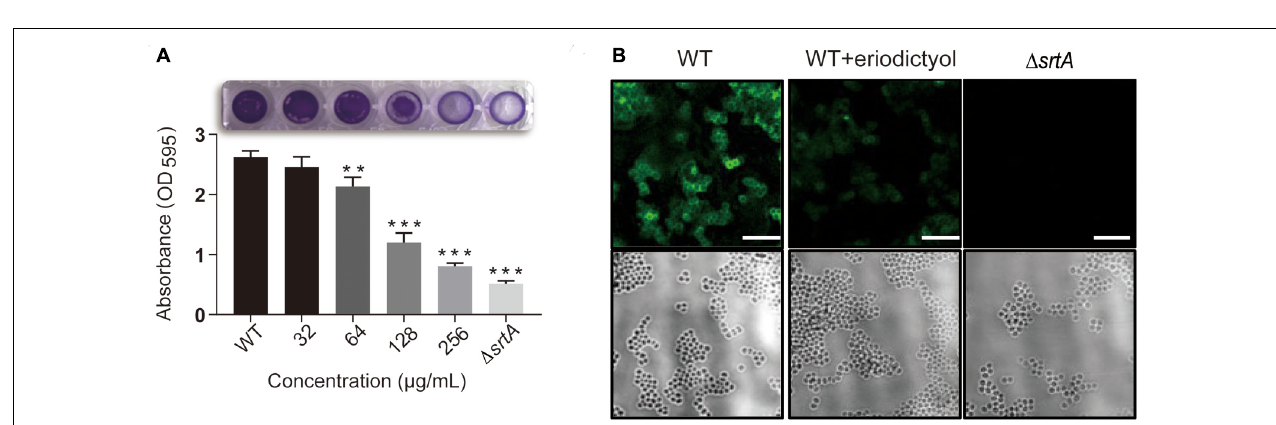
FIGURE 3 | Eriodictyol inhibits SrtA activity in vitro . (A) Biofilm formation of S. aureus in the presence of eriodictyol. The formation of the biofilms was quantified by the crystal violet (CV) staining assay. (B) Confocal laser microscopy analysis of S. aureus surface protein (SpA) stained with FITC-labeled rabbit IgG. Magnification: 600 × ; scale bar, 50 µ m. The data are shown as the mean ± SEM (error bars) of three replicates. ** P < 0.01, *** P < 0.001 vs. the WT group according to the two-tailed Student’s t -test.